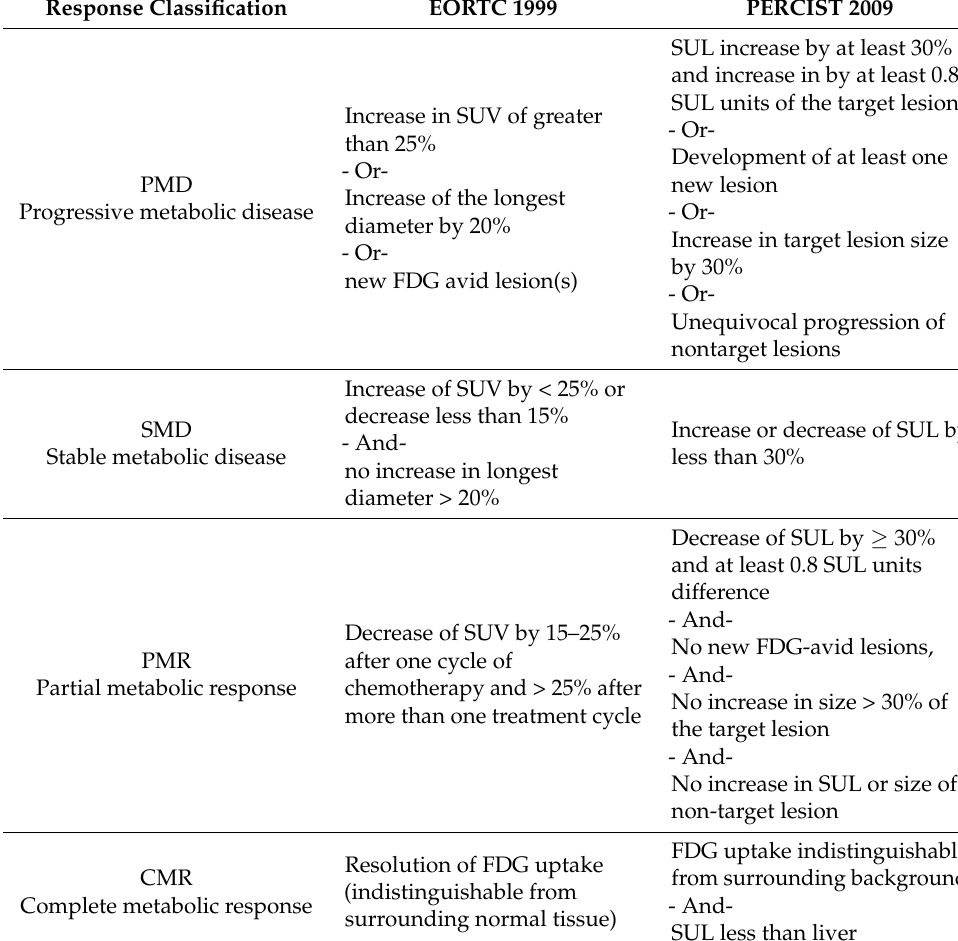
Table 2. FDG criteria for response (modified from References